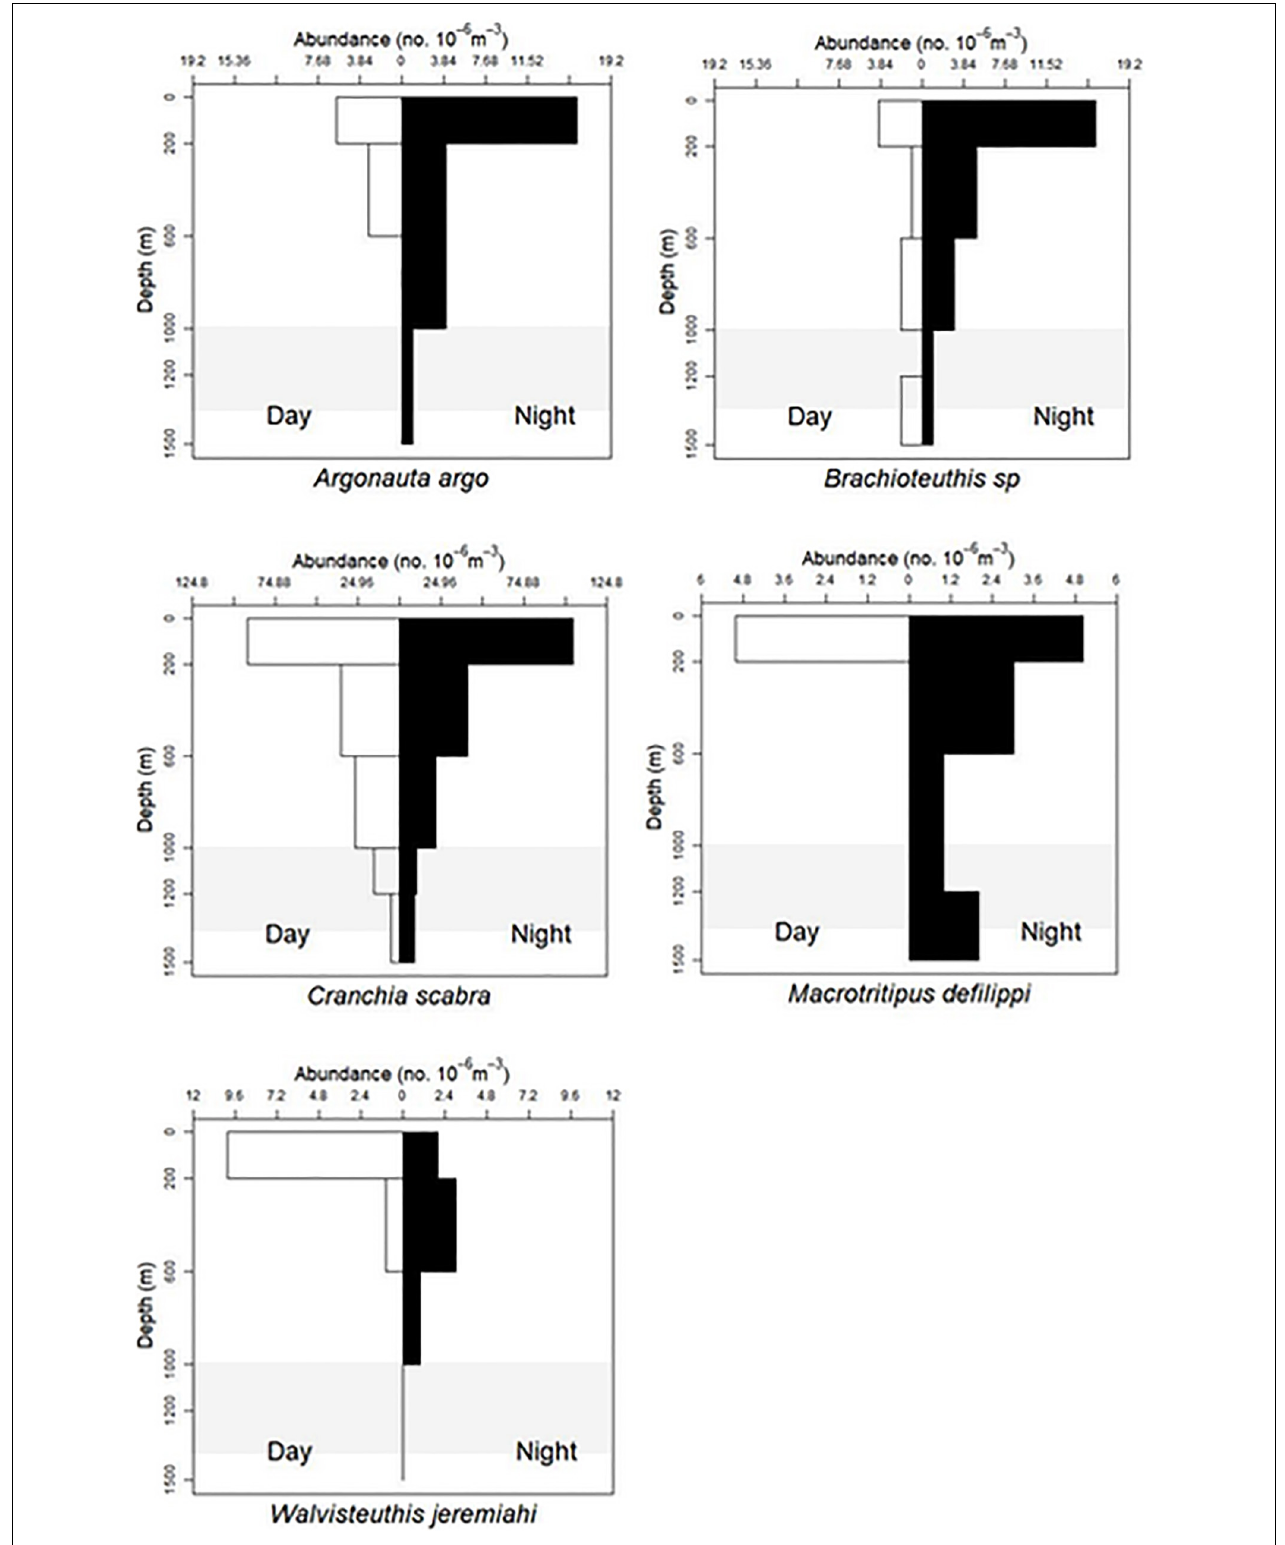
FIGURE 3 | Vertical distribution patterns of five cephalopods. Holoepipelagic non-migration pattern described by T. Sutton et al. (unpublished). A. argo , n = 35; Brachioteuthis sp., n = 35; C. scabra , n = 353; M. defilippi , n = 17; W. jeremiahi , n = 17; shaded region indicates the deep oil plume zone.